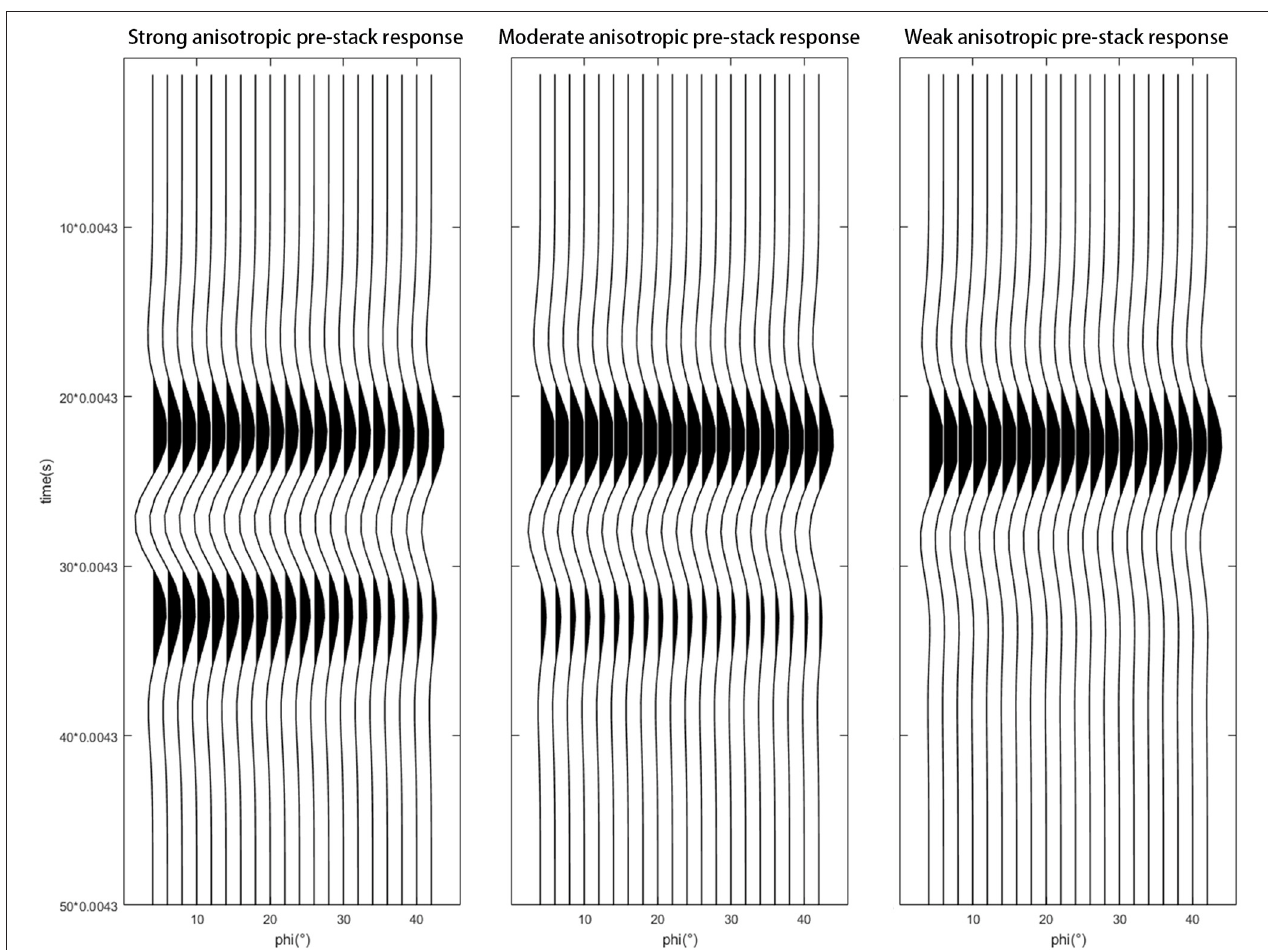
FIGURE 3 | Qualitative model pre-stack response.